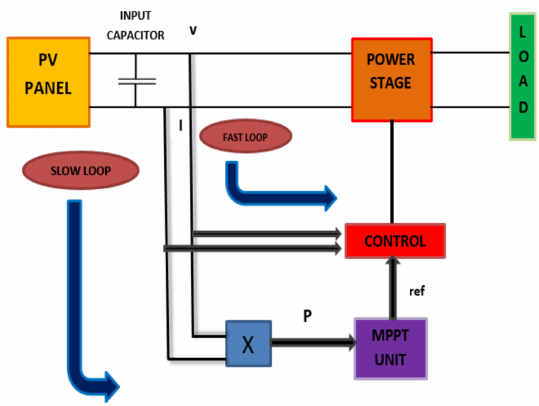
Figure 5. Schematic representation of the Sliding Mode Control algorithm.